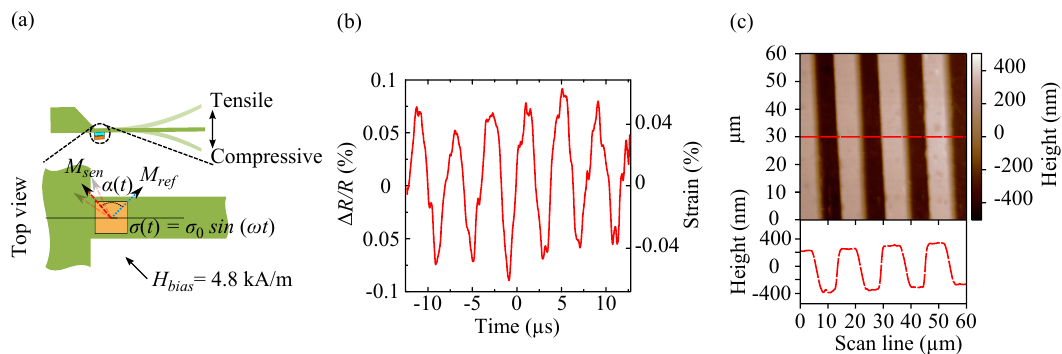
Figure 7. ( a ) Oscillation of an AFM cantilever at its resonance frequency; ( b ) The increase and the decrease in the tunnel resistance are correlated to the stress alternation. The oscillating signal or ∆ R / R is detected using a manually balanced Wheatstone bridge configuration, in which the TMR sensor is incorporated; ( c ) Dynamic imaging of a PMMA grating in amplitude modulation mode recorded by a TMR sensor. Panel ( c ) is reproduced from [6] with permission of AIP